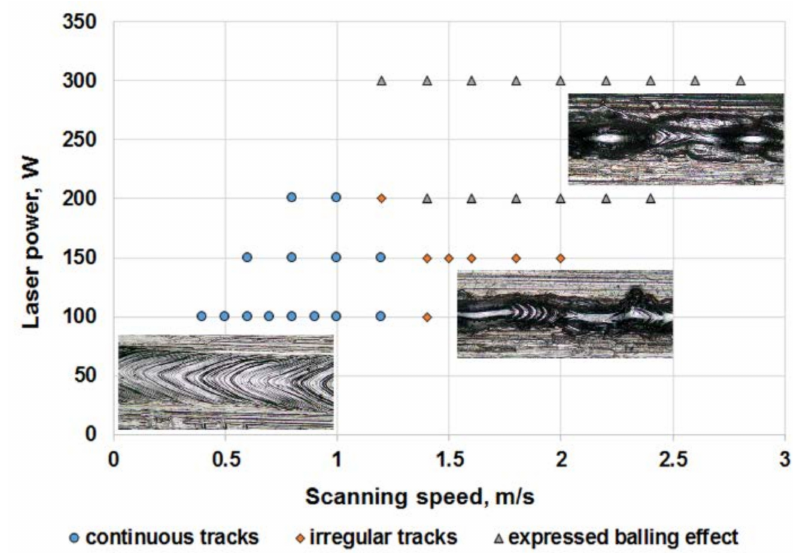
Figure 3. Process map obtained on the 100–300 W laser power and 80 µ m laser spot diameter (“low-power